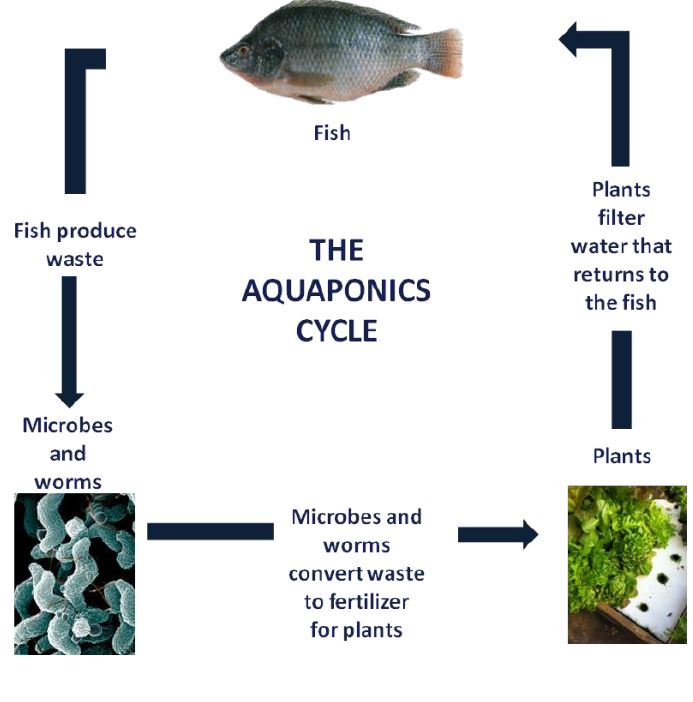
Figure 1. Diagrammatic representation of the aquaponic